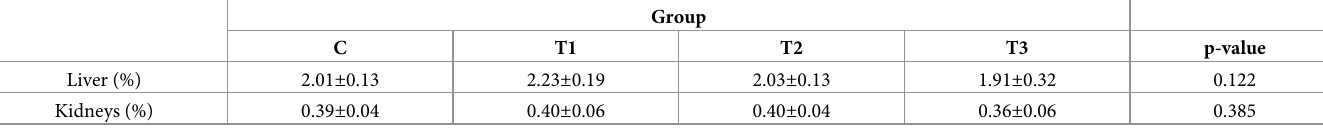
Table 5. Liver and kidneys percentage (%) of body